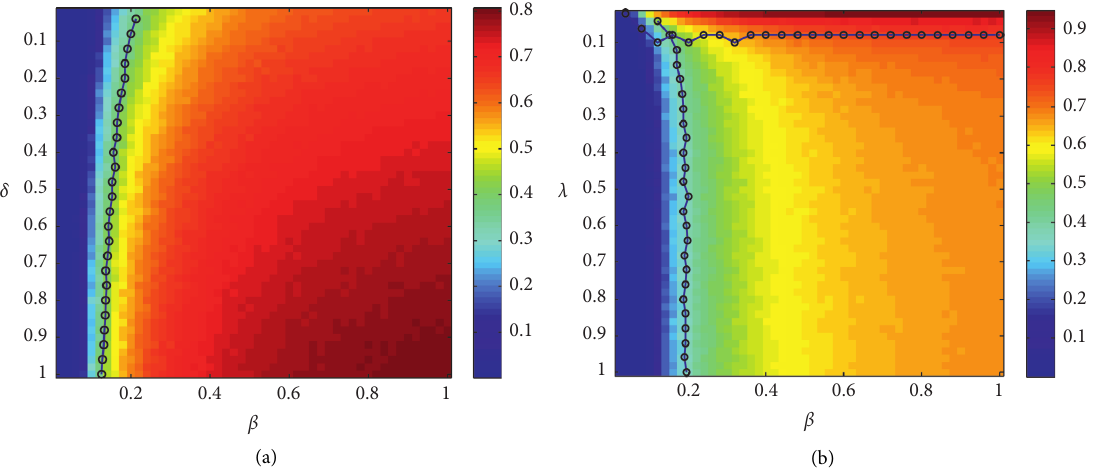
Figure 5: The heat maps of ρ I as a function of a pair of δ and β (a) and λ and β (b). The longitudinal curve in Figures 5(a) and 5(b) indicates the theoretical outbreak thresholds of β obtained by solving equation (13), which is the same as those in Figure 7. And, the transverse curve in Figure 5(b) indicates the simulated outbreak thresholds of λ obtained by the variability measurement, which affects the outbreak of epidemic. It trivially fluctuates only when β is less than 0.2. These two subfigures clearly show that δ and λ affect the outbreak thresholds of each other and effectively affect the outbreak of the epidemic, which suggests that resource diffusion can play an important role in the control of epidemic spreading. The other fixed parameters are λ � 0 . 64 for (a), δ � 0 . 10 for (b), μ � 0 .